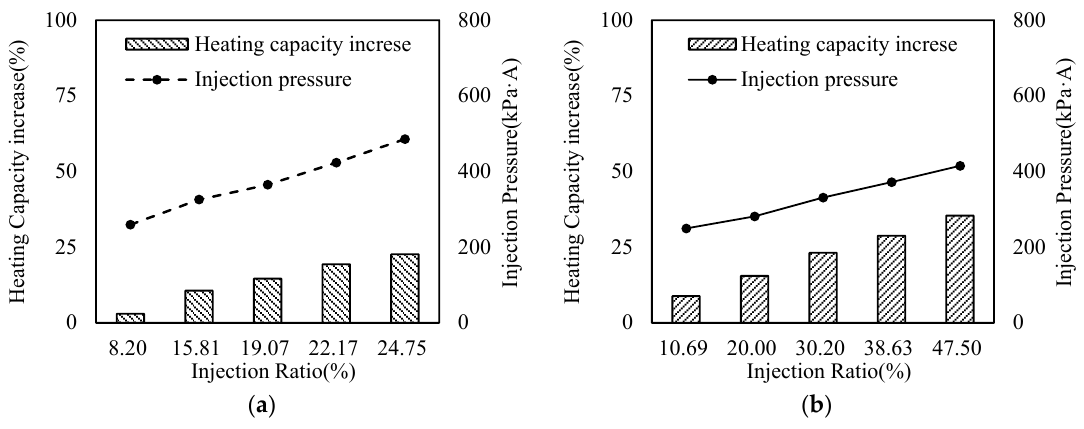
Figure 5. Comparison of EVI heating performance to the baseline. ( a ) Results of test condition No. 4; ( b ) Results of test condition No. 5.